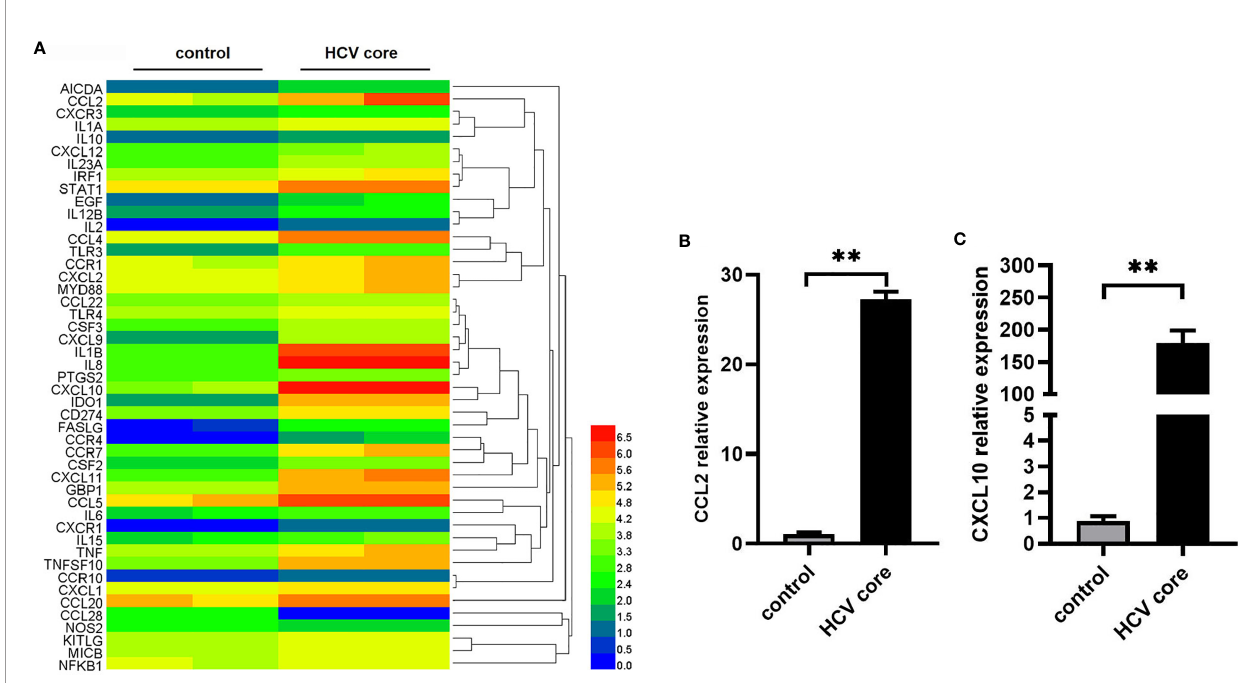
FIGURE 1 | Identi fi cation of differentially expressed genes in macrophages treated with HCV core protein. (A) Heat map showing the gene expression pro fi le data in macrophages (M F -THP-1) treated or untreated with HCV core protein (10 m g/mL) for 8 h based on PCR array analysis. Red: up-regulation; Blue: down-regulation. (B, C) M F -THP-1 were treated or untreated with HCV core protein (10 m g/mL) for 8 h. Relative expressions of CCL2 and CXCL10 were determined by quantitative real-time PCR (qPCR). Data are shown as mean ± SD for three independent experiments. ** p <